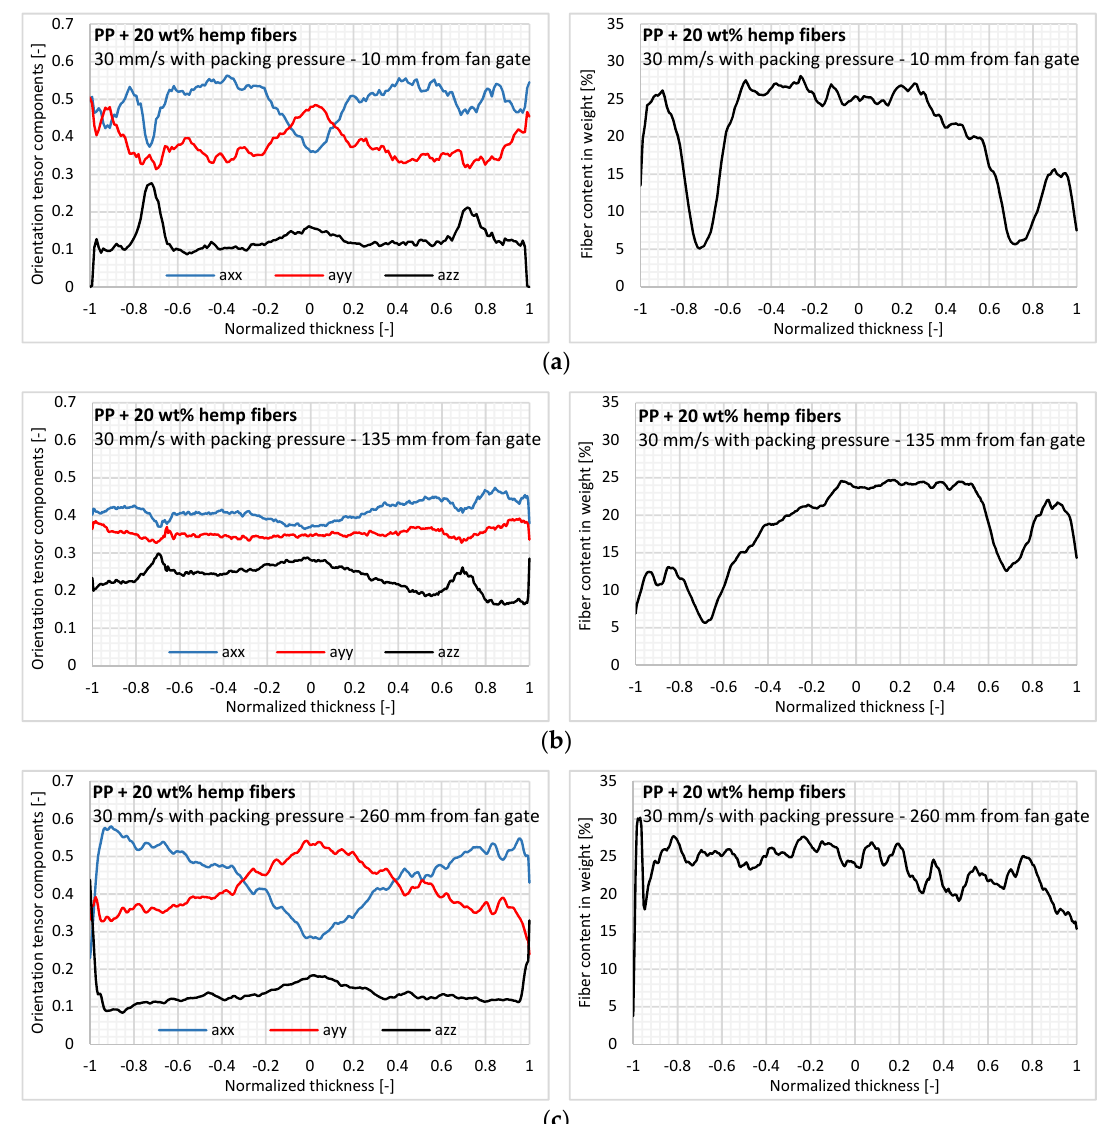
Figure 10. In-thickness fiber orientation and fiber content for the three regions of the injected part: ( a ) Entry, ( b ) lubrication, and ( c ) near-end-of-fill.